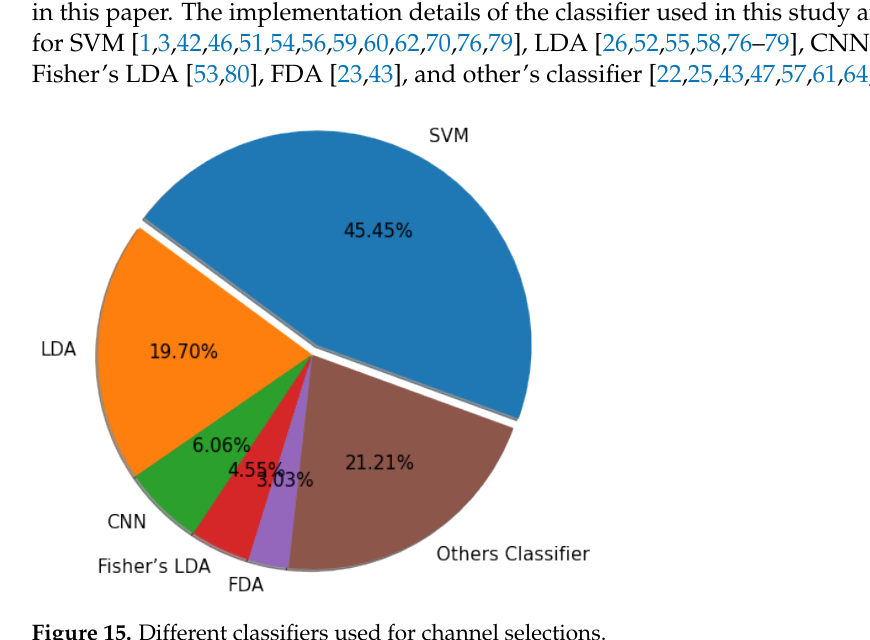
Figure 15. Different classifiers used for channel selections.